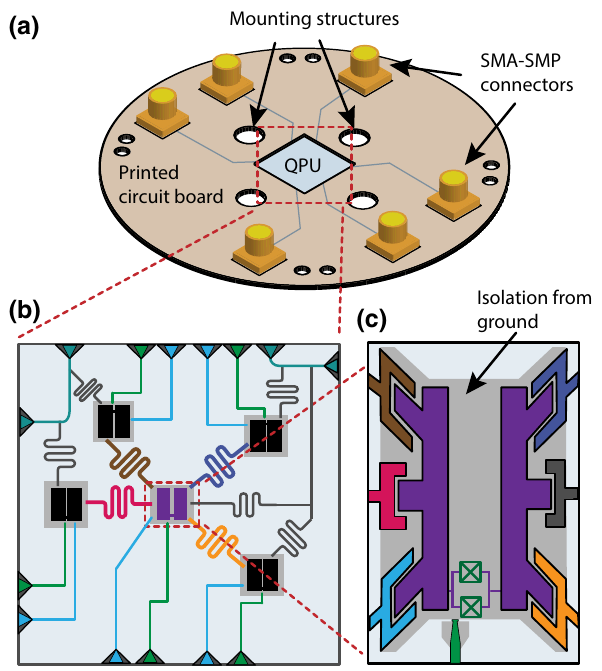
FIG. 6. A typical example of a planar cQED system. (a) A superconducting chip embedded in a printed circuit board (PCB) via wire bonds. The PCB provides the structures for ground- ing, microwave interconnects, and mounting elements to the sample box. (b) A more detailed view of a typical multiqubit chip together with resonator buses and readout modes (dark gray). Each qubit can be controlled via on-chip flux (green) or microwave (blue) drive lines. (c) A typical flux-tunable transmon qubit capacitively coupled to several resonator